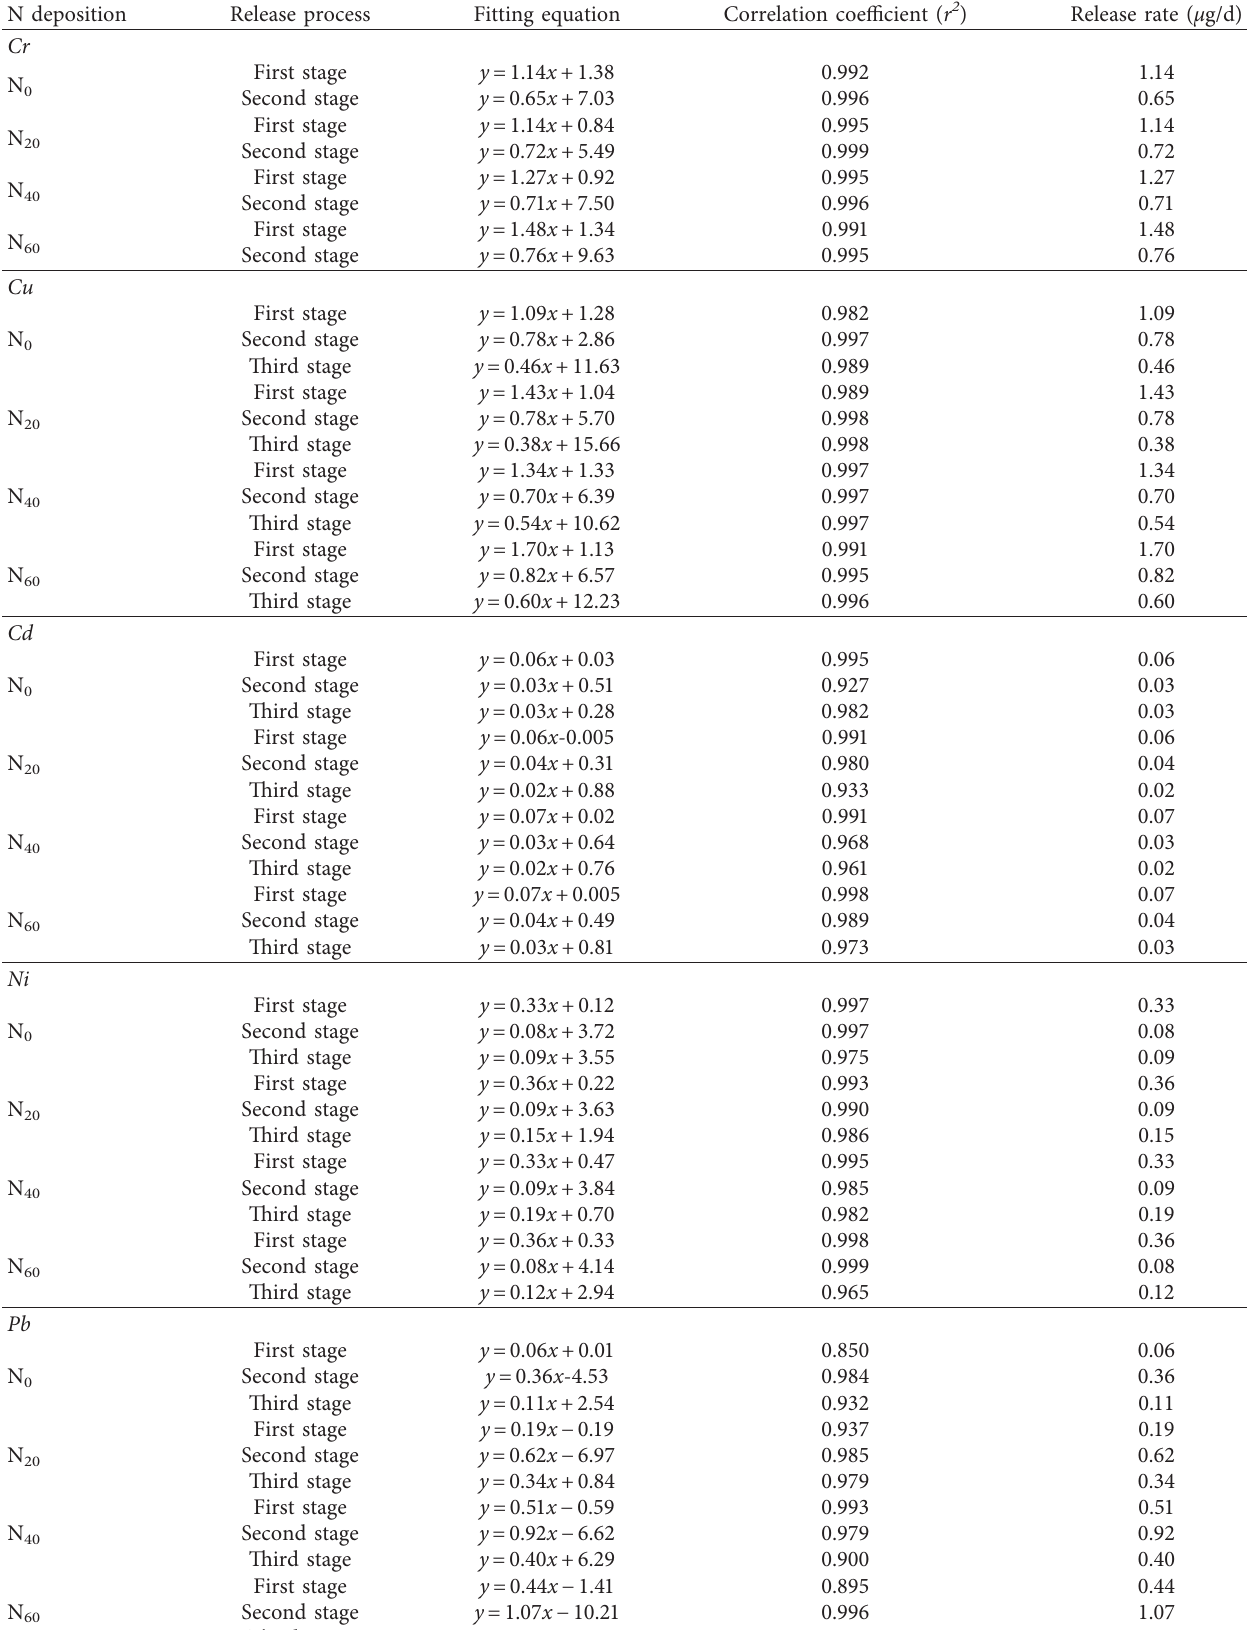
Table 3: Fitting functions of cumulative release amounts and the release rates of